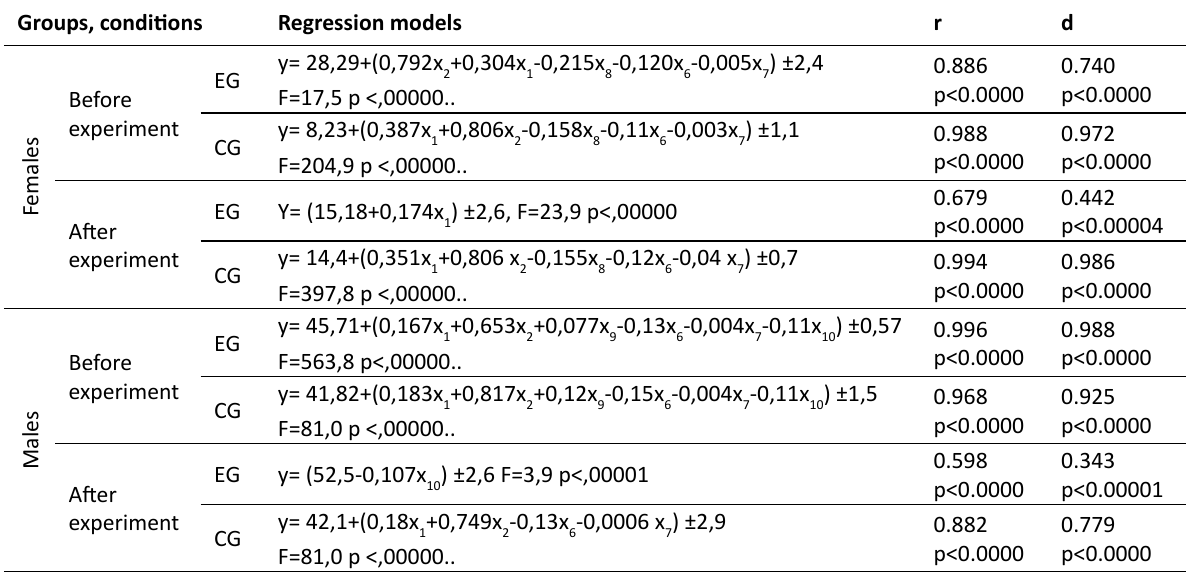
Table 1. Маthematical dependence models of the biological age of males and females of EG and CG on anthropometric and functional indices before and after the experiment Groups, conditions Regression